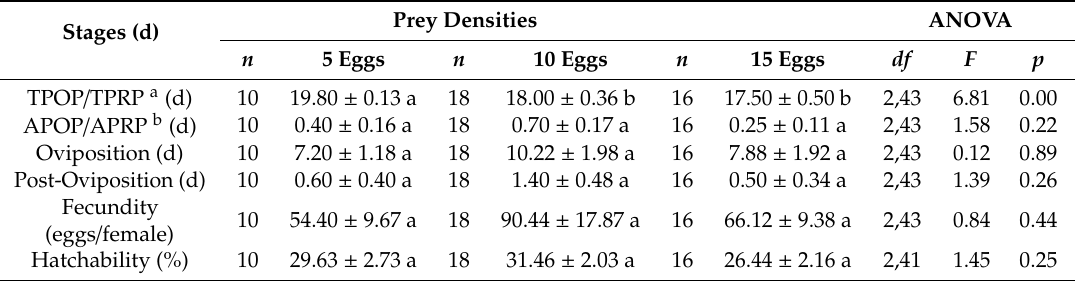
Table 3. E ff ect of three prey densities on the biological traits of O. strigicollis feeding on P. gossypiella